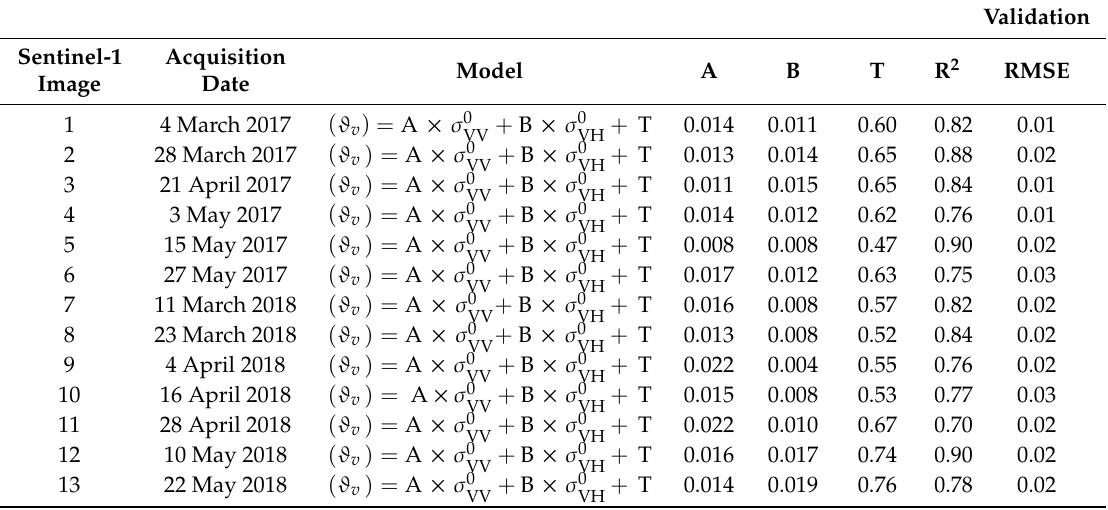
Table 5. Empirical constants (A, B, and T) of the localized model. The total number of samples for each date was 62. The linear equation was derived using 70% of the total population.